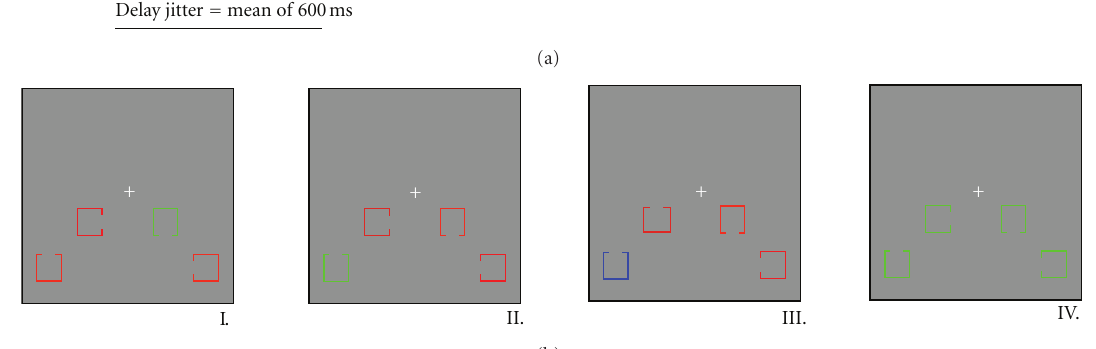
Figure 1: Experimental paradigm. Image (a) presents the experimental design. Image (b) presents the di ff erent type of stimuli: I. frequent position of the square opening (standard stimulus), II. infrequent position of the square opening (target stimulus), III. infrequent colour of the target stimulus, and IV. same colour stimulus. Colour of di ff erent type of stimuli was counterbalanced among